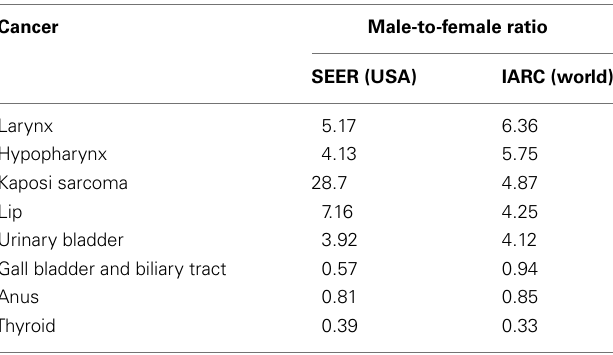
Table 1 | Selected cancers with the highest and lowest male-to-female